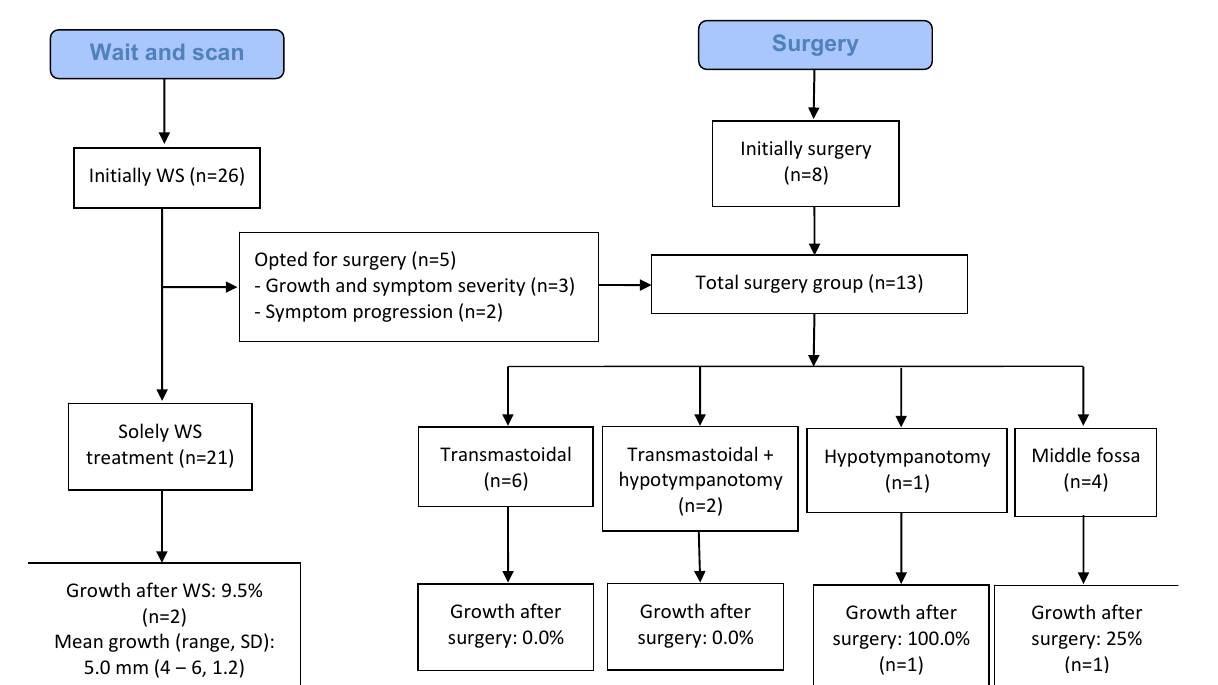
Figure 2. Routing of patients with outcome. Table 2. Reported symptoms and clinical